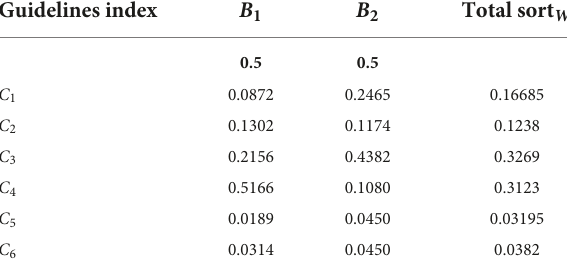
TABLE 9 Hierarchical single sorting and total sorting